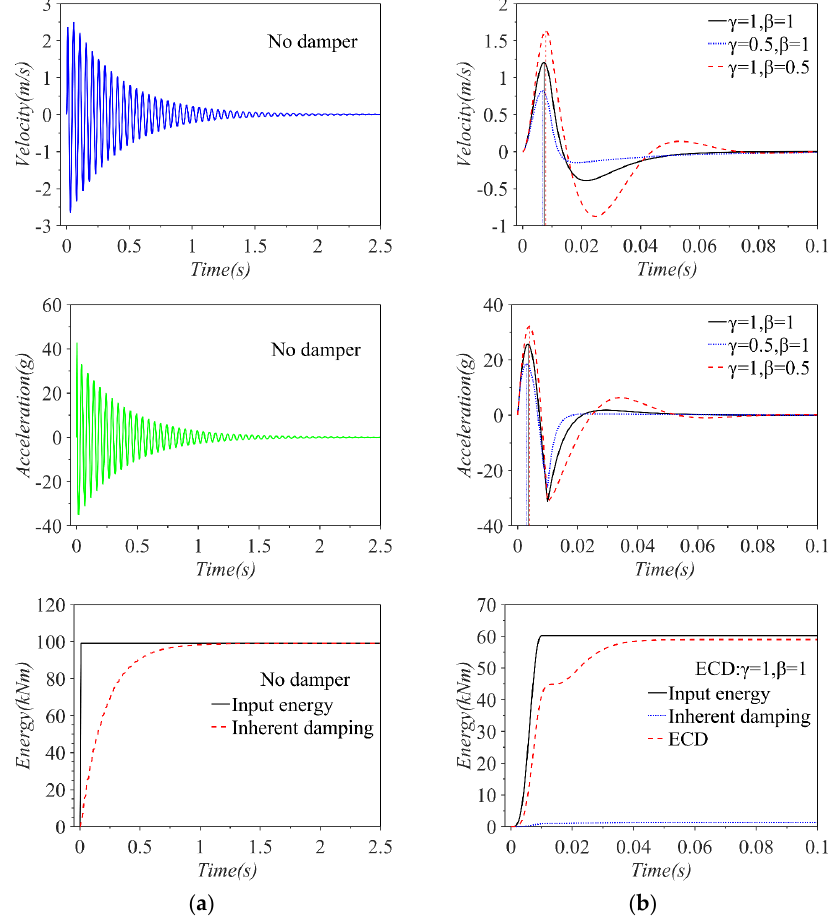
Figure 5. Time − histories for displacement, velocity, acceleration, and energy of the SDOF system subjected to half-cycle sine shock: ( a ) Without damper; ( b ) With an ECD. Table 2. Adjusted acceleration loads.